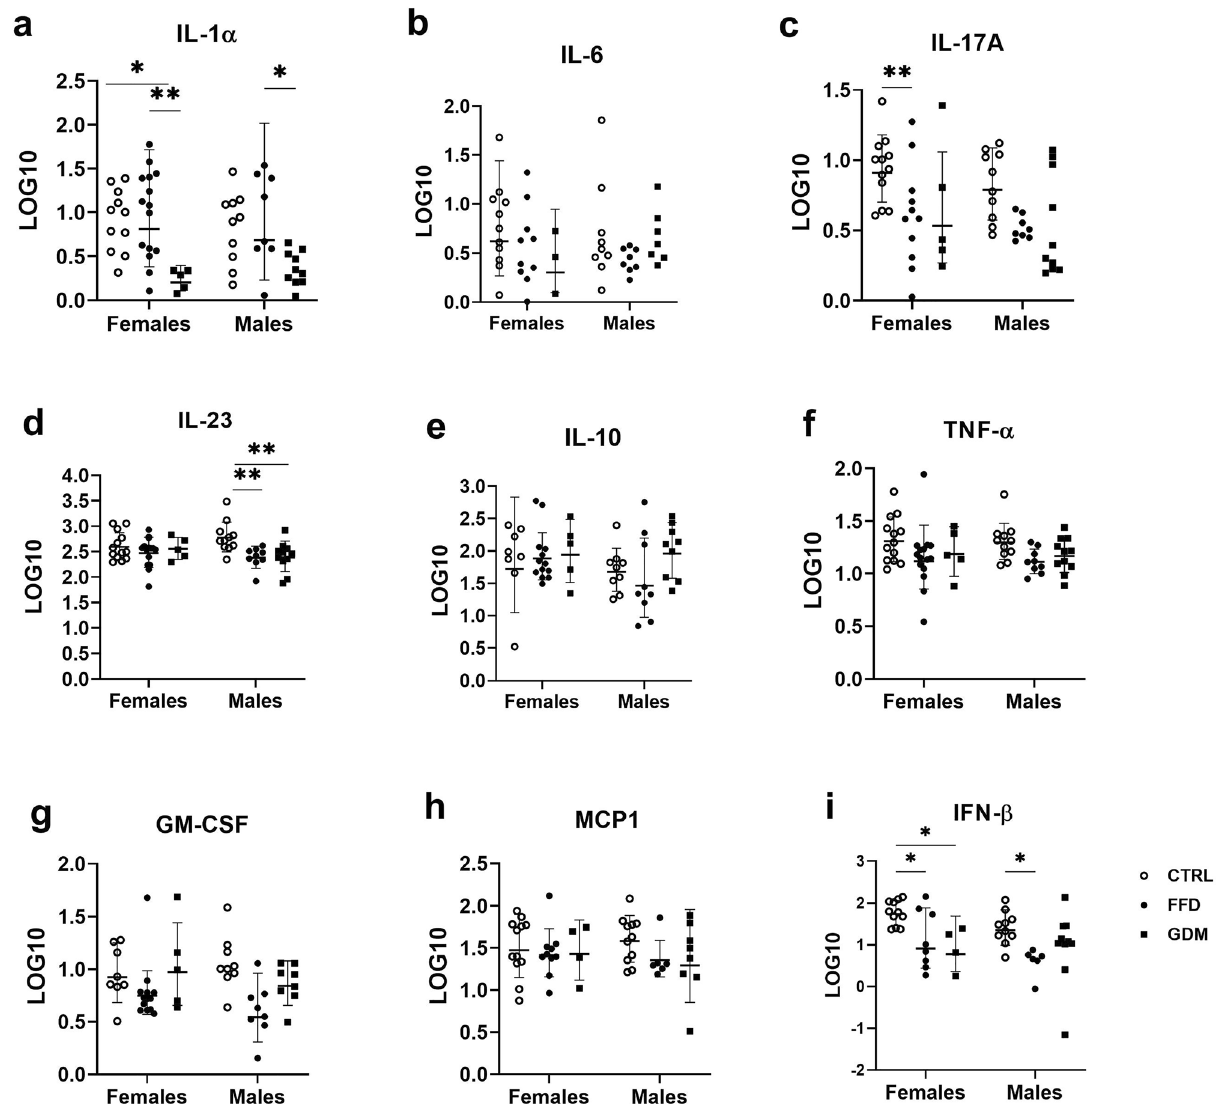
Figure 5. Inflammatory markers in the offspring. ( a ) Interleukine-1 alpha: p group < 0.001, p sex = 0.884, p diet*sex interaction = 0.866; ( b ) interleukine-6: p group = 0.066, p sex = 0.716, p group*sex interaction = 0.704; ( c ) interleukine- 17A: p group < 0.001, p sex = 0.395, p group*sex interaction = 0.603; ( d ) interleukine-23: p group = 0.005, p sex = 0.739, p group*sex interaction = 0.113; ( e ) interleukine-10: p group = 0.498, p sex = 0.344, p group*sex interaction = 0.416; ( f ) tumor necrosis factor-alpha: p group = 0.019, p sex = 0.626, p group*sex interaction = 0.992; ( g ) granulocyte–macrophage colony-stimulating factor: p group = 0.030, p sex = 0.197, p group*sex interaction = 0.717; ( h ) monocyte chemoattractant protein-1: p group = 0.293, p sex = 0.824, p group*sex interaction = 0.673; ( i ) interferon-beta; p group < 0.001, p sex = 0.107, p group*sex interaction = 0.468; *p < 0.05, **p < 0.01, ***p < 0.001; groups: CTRL offspring of dams consuming control diet, FFD offspring of dams administered fast-food diet (cheeseburgers), GDM offspring of dams with gestational diabetes mellitus, Log10 decadic logarithm, markers are given in